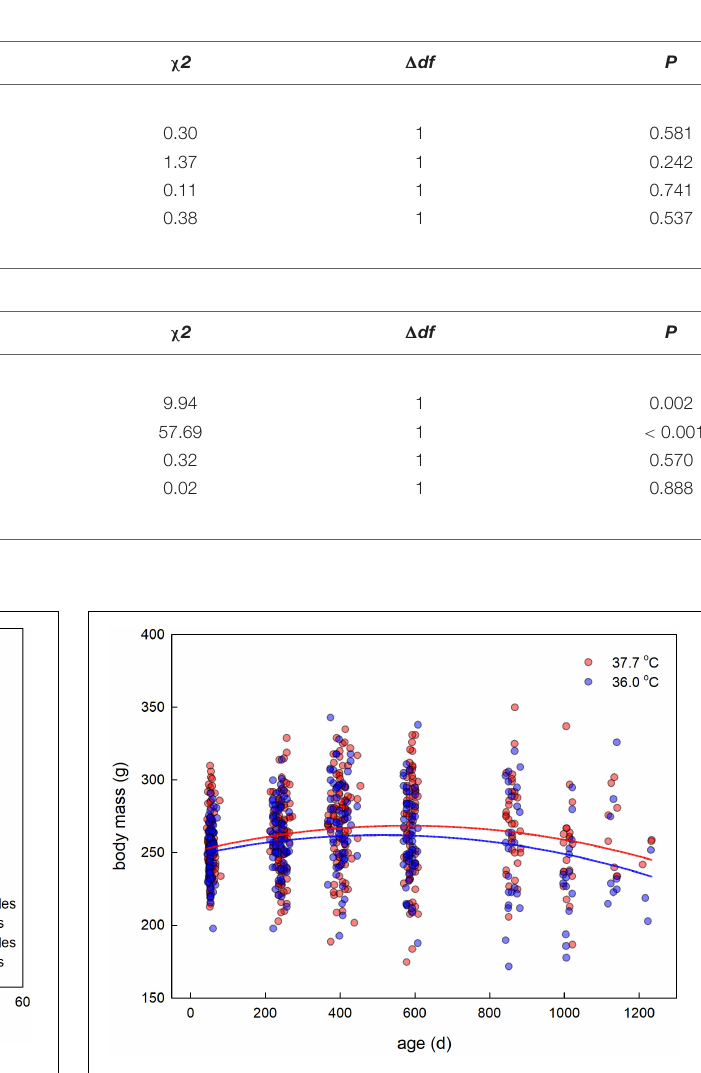
FIGURE 1 | Post-hatching body mass (average ± SE) plotted against age for male and female Japanese quail incubated at 37.7 ◦ C ( n = 203 hatchlings) or 36.0 ◦ C ( n = 184 hatchlings). The lines represent the growth in the first six weeks after hatching. Although growth between 7 and 42 days old may appear linear, effects of the treatment were analyzed with age as a categorical variable (see Table 1 ). The final data points (with bi-directional error bars) represent the average age ( ± SE) and average mass ( ± SE) at sexual maturity, for each category.